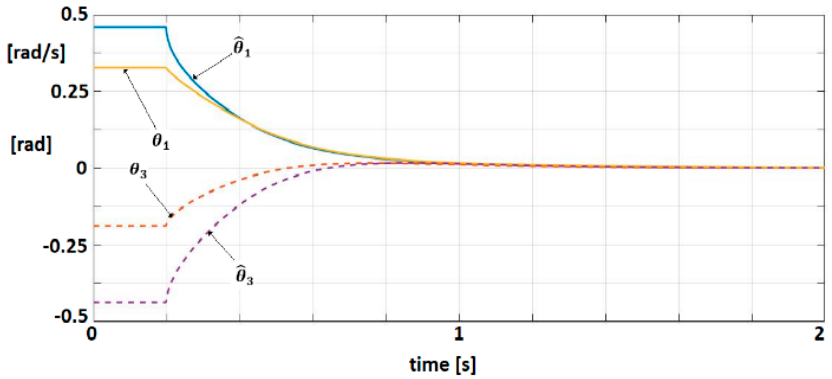
Figure 10. Trajectories of position and velocity for the system and observer.